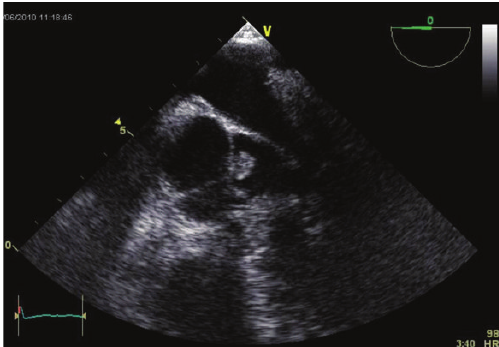
Figure 1: Echo image.